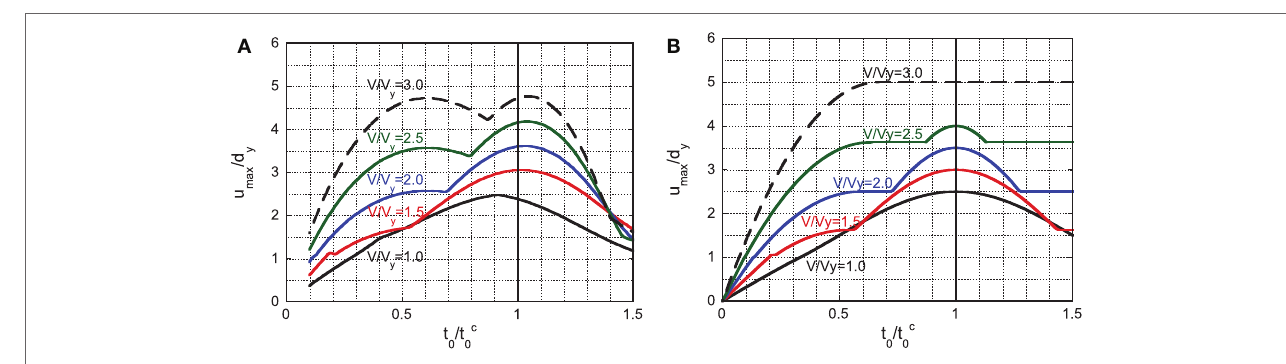
0c / : (a) sinusoidal input and (B) double 0